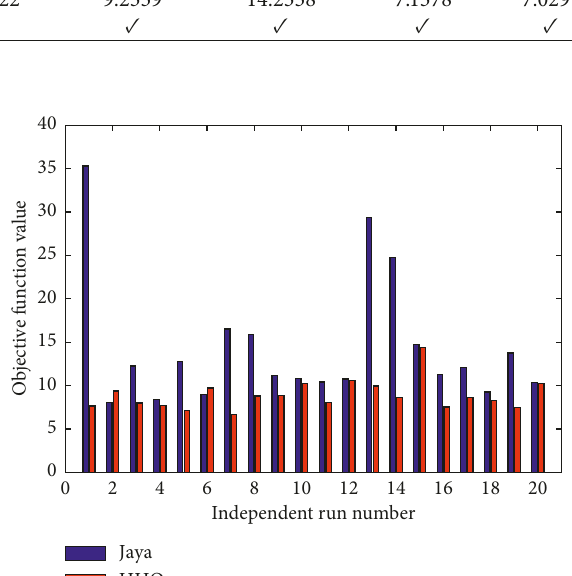
Figure 14: Convergence characteristics for the 9-bus system by NLP formulation. Figure